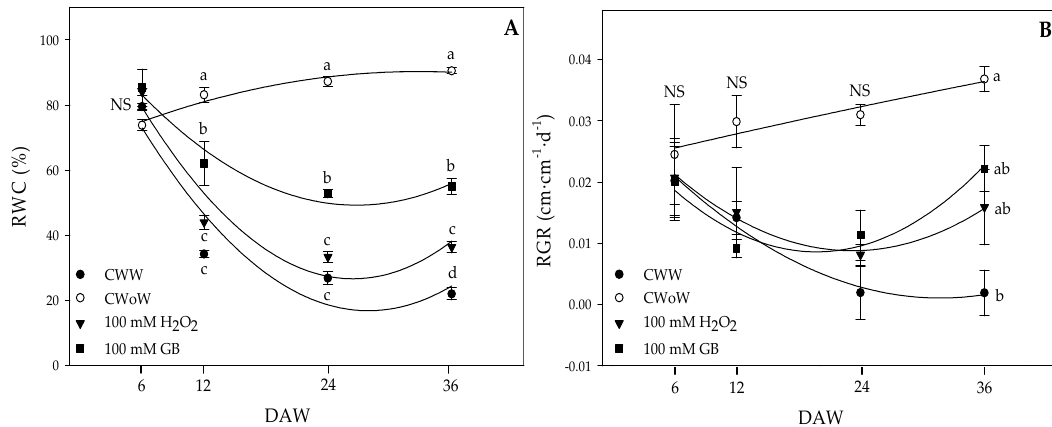
Figure 2. ( A ) Relative Water Content (RWC) and ( B ) Relative Growth Rate (RGR) of Cape gooseberry ( Physalis peruviana L.) plants ecotype Colombia subjected to two waterlogging periods. Filled circle: control treatment subjected to waterlogging, circle without filling: control treatment without waterlogging, filled triangle: treatment with a concentration of 100 mM of H 2 O 2 , filled square: treatment with a concentration of 100 mM of GB. Evaluated at 6, 12, 24, and 36 days after waterlogging (DAW). Data represent the mean of five plants ± standard error per treatment ( n = 5). Points followed by different letters indicate statistically significant differences according to the Tukey test ( p ≤ 0.05).